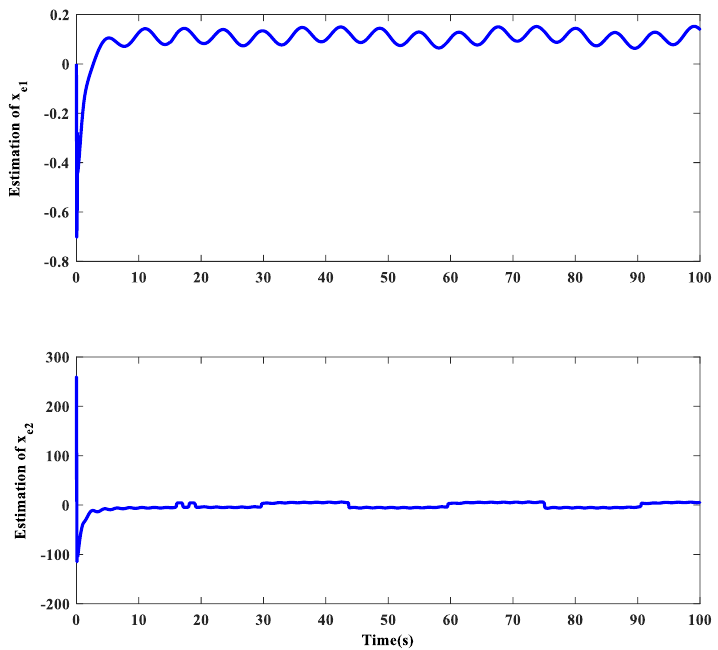
Figure 13. The disturbance estimations of the ADRAC.